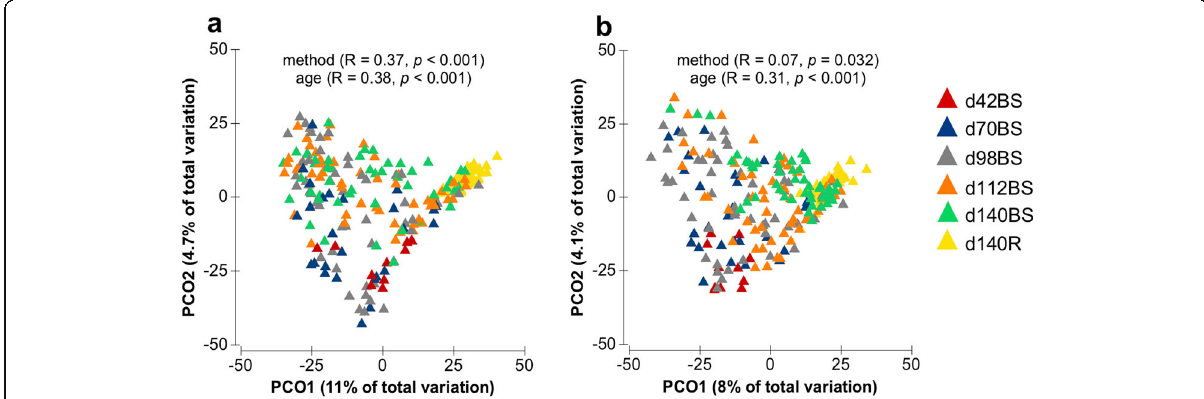
Fig. 1 Principal coordinates analysis plots depicting the distribution of bacterial communities in 233 samples collected via two different sampling methods (buccal swabbing (BS) and stomach tubing (R)) from different age group calves, without exclusion ( a ) or after exclusion ( b ) of potential oral taxa by mathematical filtering approach. Each point represents one sample. Different age groups are indicated by different coloured